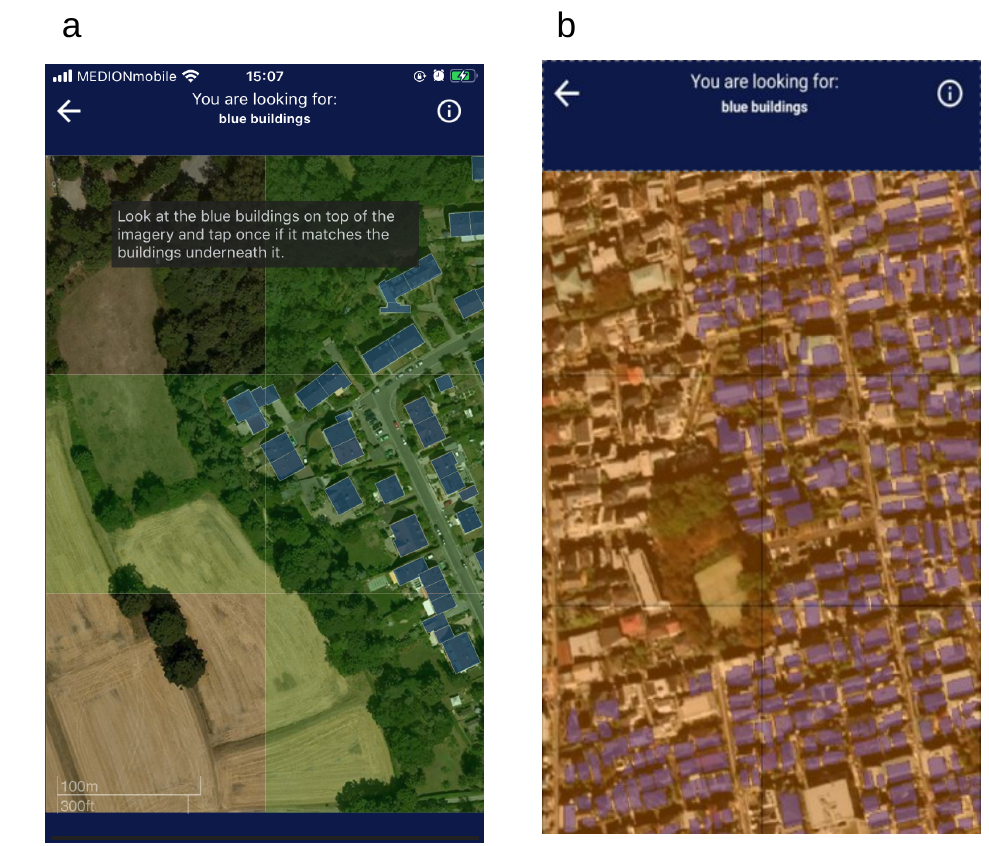
Figure 1. MapSwipe main screen. Two examples are given: ( a ) Green-colored tiles represent complete tiles, untapped tiles represent no building tiles; ( b ) Orange-colored tiles represent areas that are incompletely mapped in OSM with respect to building